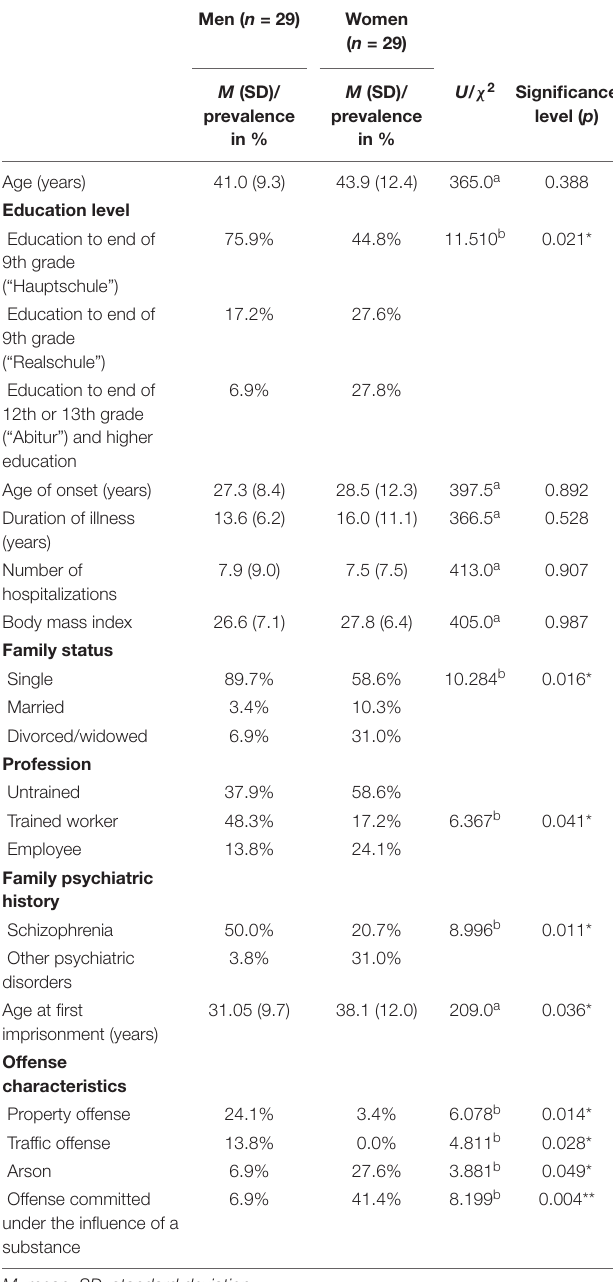
TABLE 1 | Group characteristics of male and female in-patients with